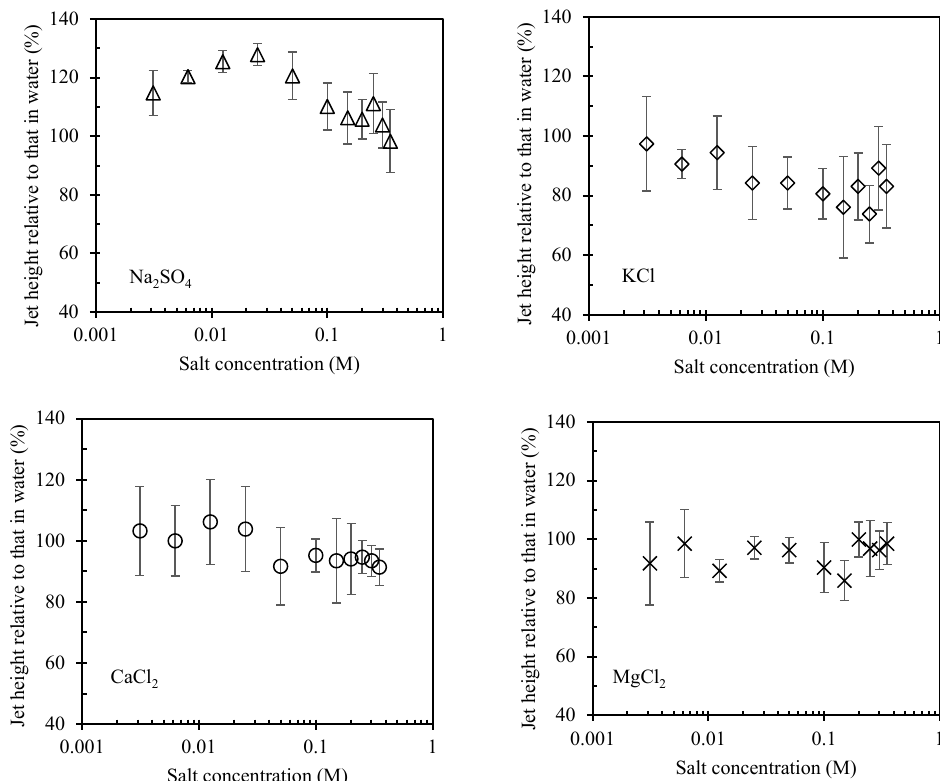
Figure A2. Maximum jet height in different salt solutions (Na 2 SO 4 , KCL, CaCl 2 and MgCl 2 ).